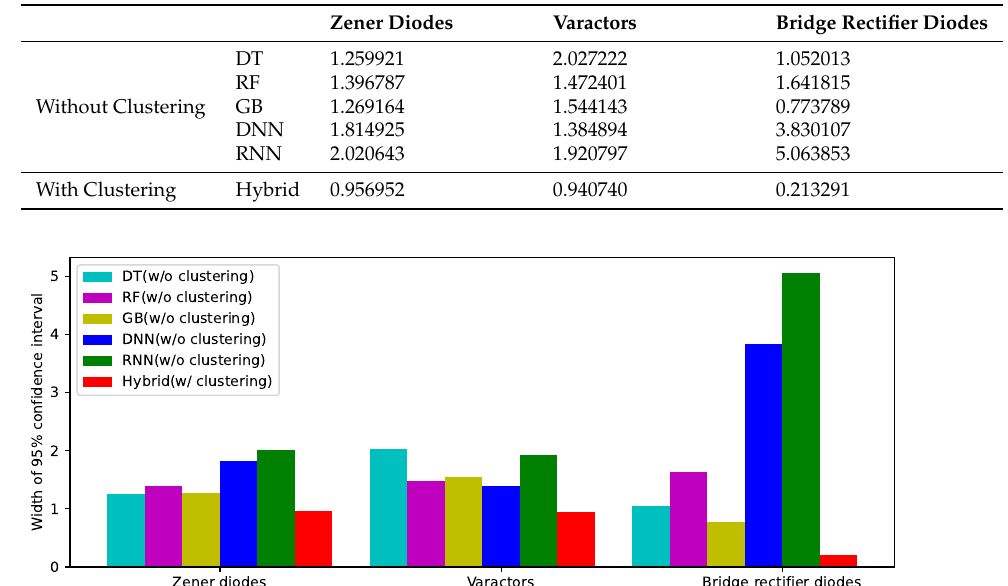
Table 13. Comparison of the widths of the 95% confidence intervals of the predicted values using various methods.